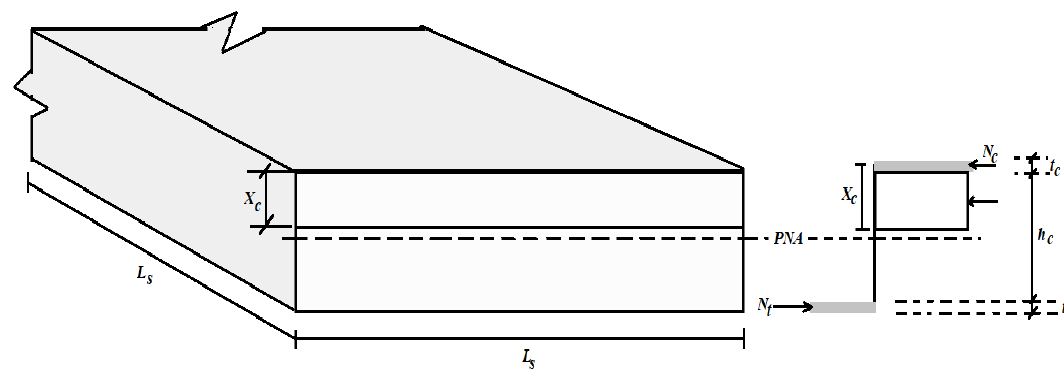
Figure 22. Force distribution in the section at the fully plastic stage.